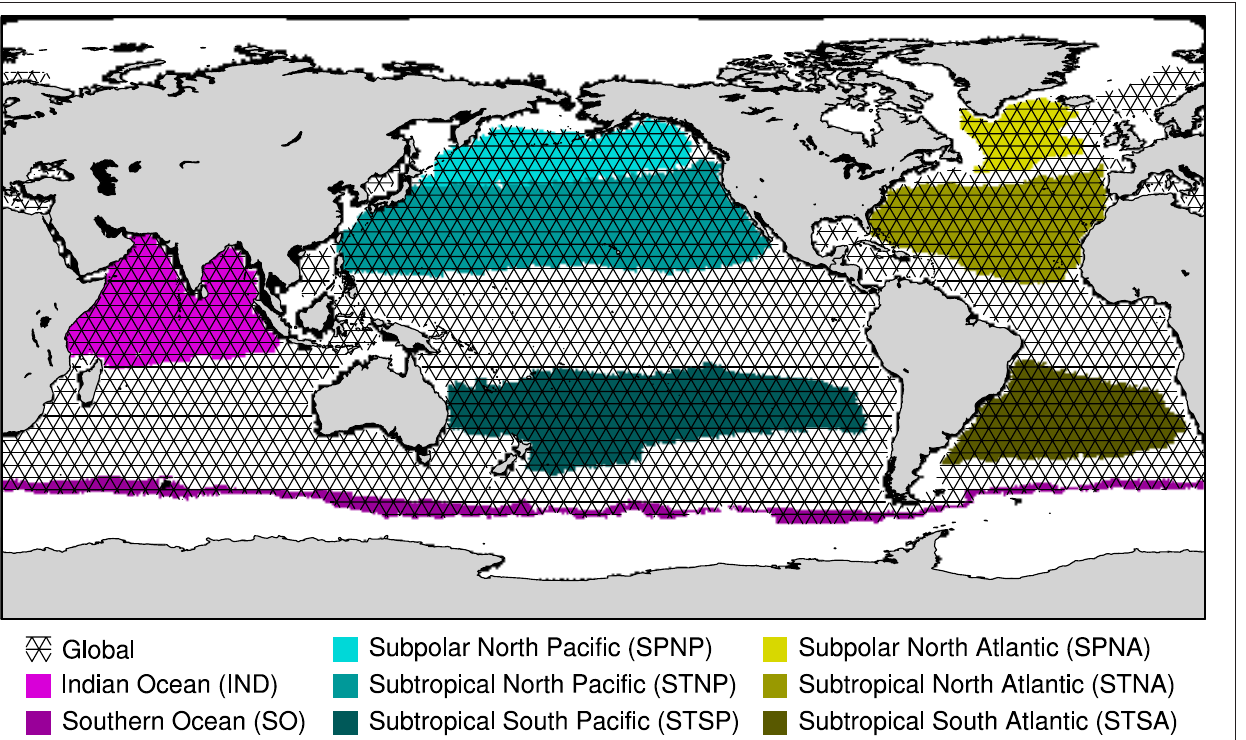
FIGURE 1 | Map of the selected regions: Subpolar North Atlantic - SPNA (light yellow); Subtropical North Atlantic - STNA (yellow); Subtropical South Atlantic - STSA (dark yellow); Subpolar North Pacific - SPNP (light cyan), Subtropical North Pacific - STNP (cyan); Subtropical South Pacific - STSP (dark cyan); Indian Ocean - IND (magenta); Southern Ocean - SO (dark magenta). The Global alkalinity enhancement region (GLOBAL) is indicated by the triangular mesh overlay. Only ice-free, open-ocean areas are included in the global and different regional